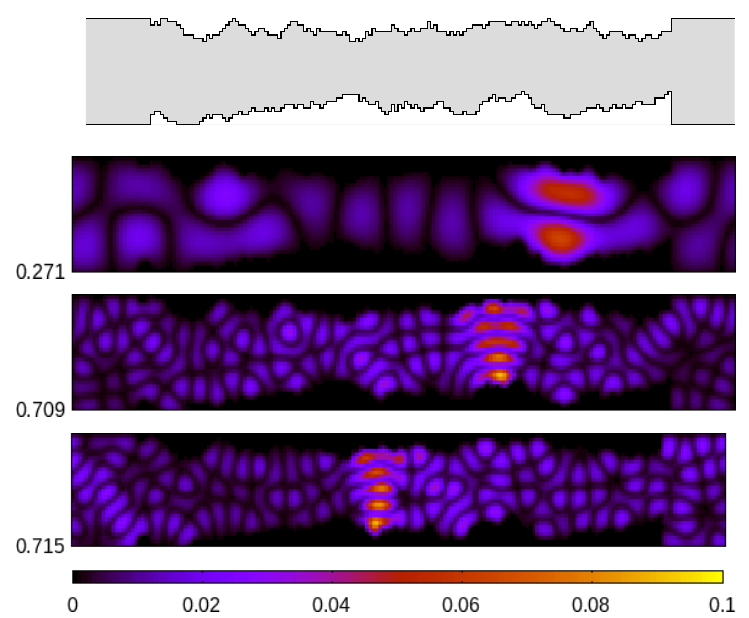
Figure 4. Acoustic phonons localized in wires with surface corrugation. Three localized eigenstates of the structure displayed on the top panel are shown (the eigenfrequency is given in the legend; for a definition of the model, see Section 4.3)